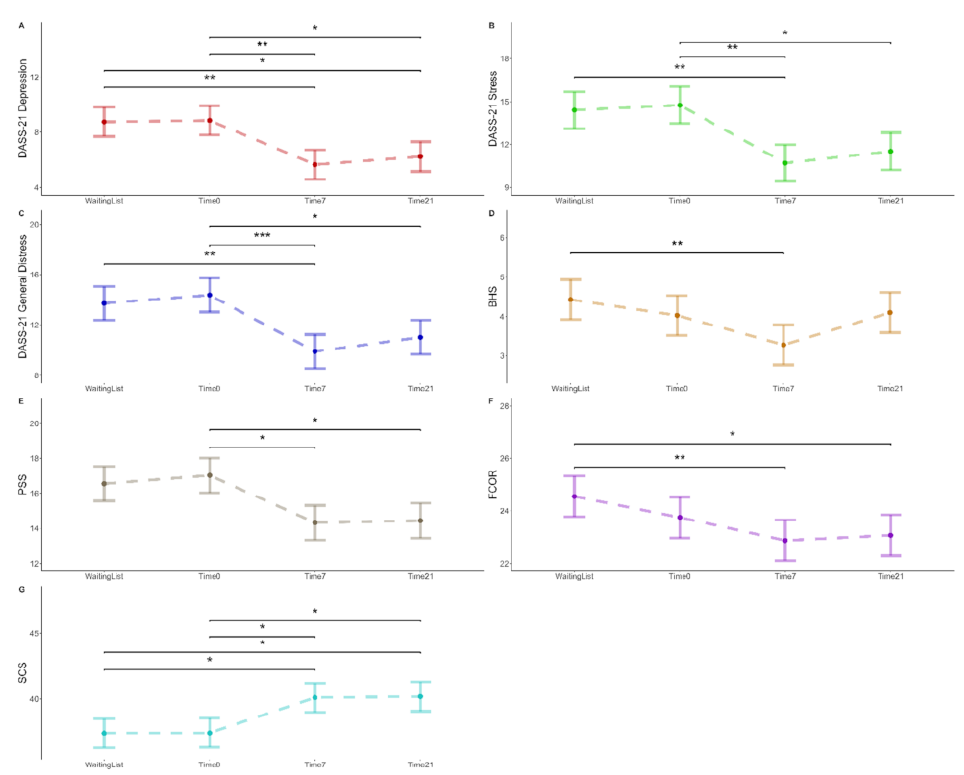
Figure 3. Bonferroni-adjusted, pairwise comparisons for Depression Anxiety Stress Scale Subscale Depression (DASS_21 Depression, ( A ) and Subscale Stress (DASS_21 Stress, ( B ), Depression Anxiety Stress Scale total score General Distress (DASS_21 General Distress, ( C ), Beck Hopelessness Scale (BHS, ( D )), Stress, Perceived Stress Scale (PSS, ( E )), Fear of Coronavirus outcome (FCOR, ( F )), and Social Connectedness Scale (SCS, ( G )) across the different time points. (7 days before the start of the intervention—Waiting Period, before the start of the intervention, Day 0—T0; end of the intervention, Day 7—T1; 2-week follow-up, Day 21—T2). * <0.05; ** <0.01; ***